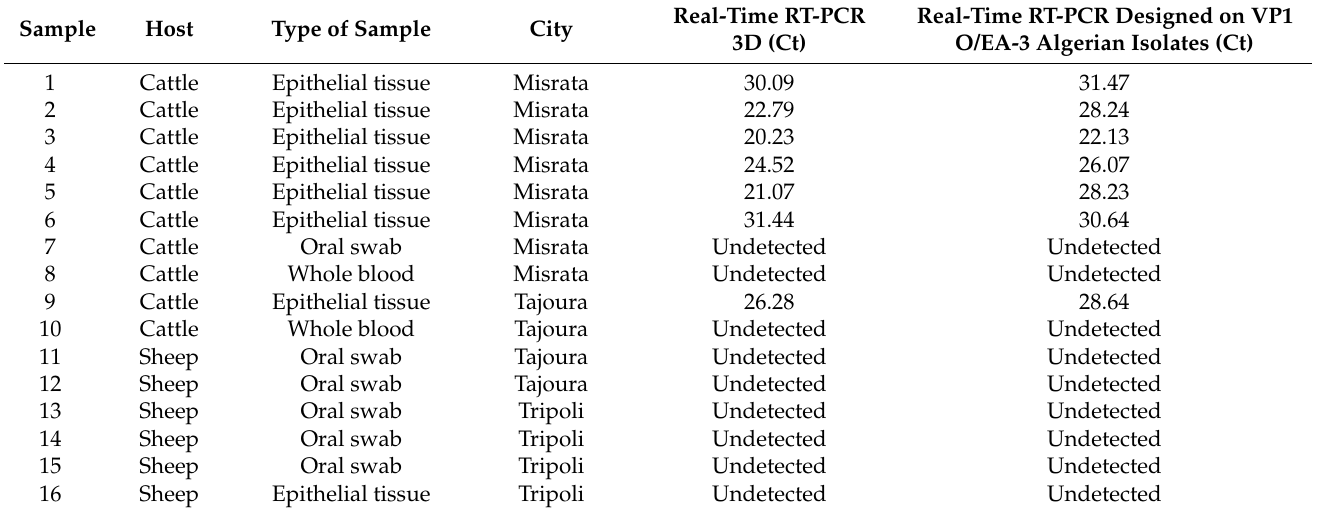
Table 3. Results of real-time RT-PCR with 3D and VP1 genes